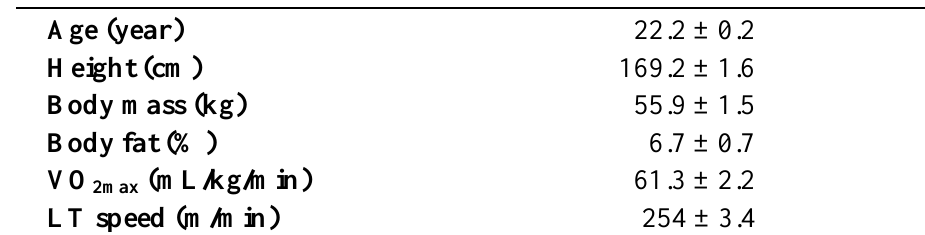
Table 1. Characteristics of the